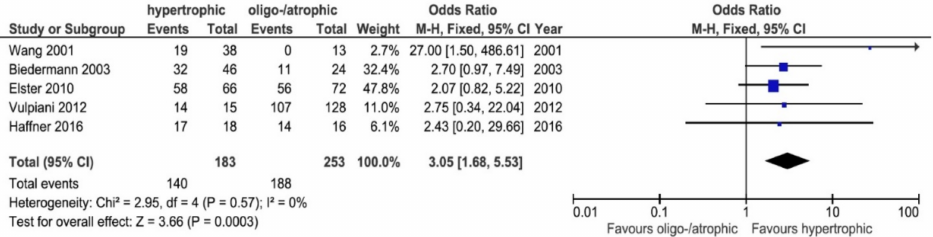
Figure 2. Forest plot of healing rates between oligotrophic or atrophic and hypertrophic cases (M–H, Mantel–Haenszel; CI, confidence interval) [11,26,38,43,46]. Events: number of patients with bone union after ESWT. Total: total of patients